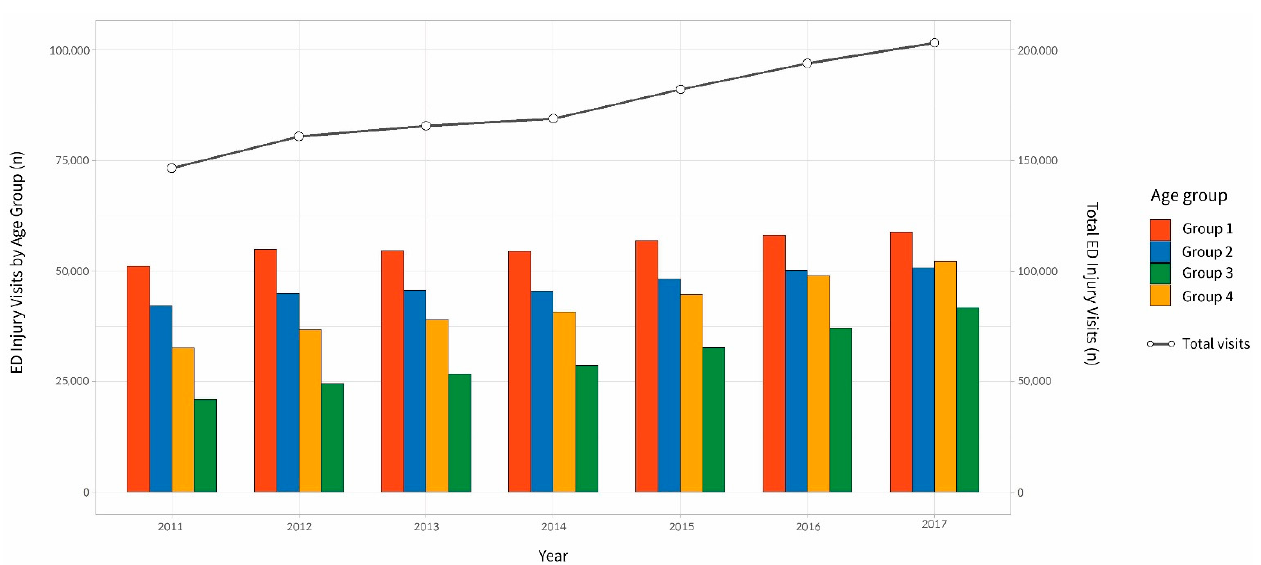
Figure 1. Emergency Department (ED) visits for injury by age group and total ED visits during 2011–2017. Group 1 (18–